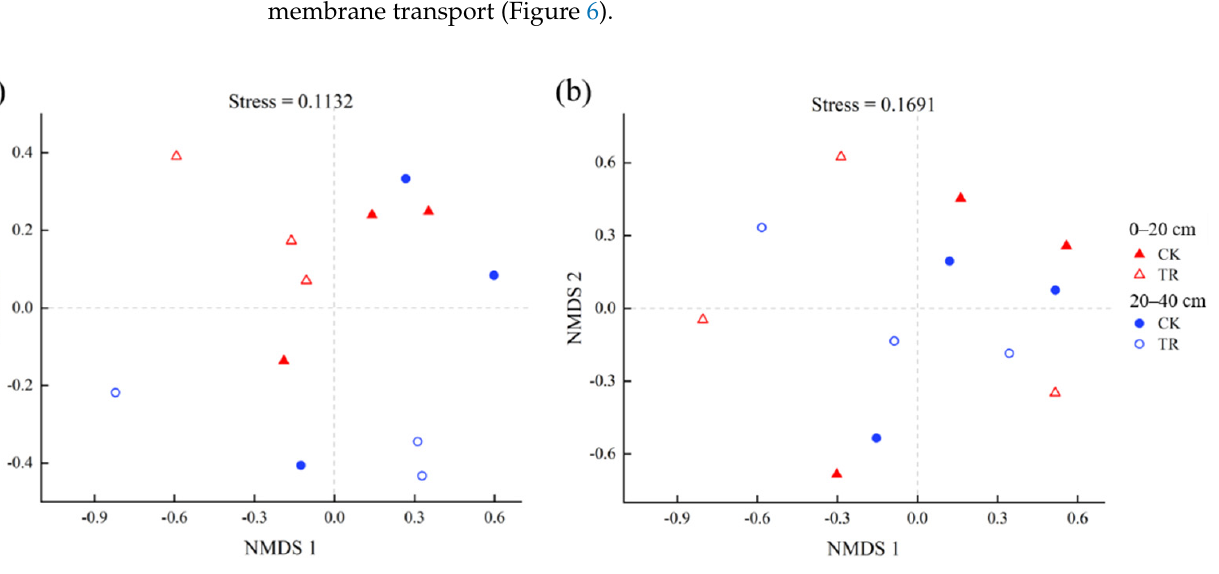
Figure 5. The biplot of redundancy analysis illustrated the relationships between bacterial ( a ) or fungal ( b ) community and the soil physicochemical properties. TN = total nitrogen, TP = total phos- phorus, AHN = alkali-hydrolyzed nitrogen, AP = available phosphorus, C:N ratio = ratio of total organic carbon and nitrogen, SWC = soil water content, TOC = total organic nitrogen, SOM = soil organic matter. 3.5. Response of Functional Groups of Bacterial and Fungal to Throughfall Reduction Based on PICRUSt2, functional analysis of bacterial populations was performed to obtain functional prediction information of different samples of bacteria. The sequencing data were compared using the KEGG database, and all samples involved a total of six types of biometabolic pathways: metabolism, genetic information processing, environ- mental information processing, cellular processes, human diseases, and organismal sys- tems (Figure 6). Among them, metabolism was the main function with the abundance of 74.51–76.02%. The analysis of the predicted functions of bacterial communities revealed that the abundance of the six primary functional depths of predicted genes did not differ significantly among treatments.